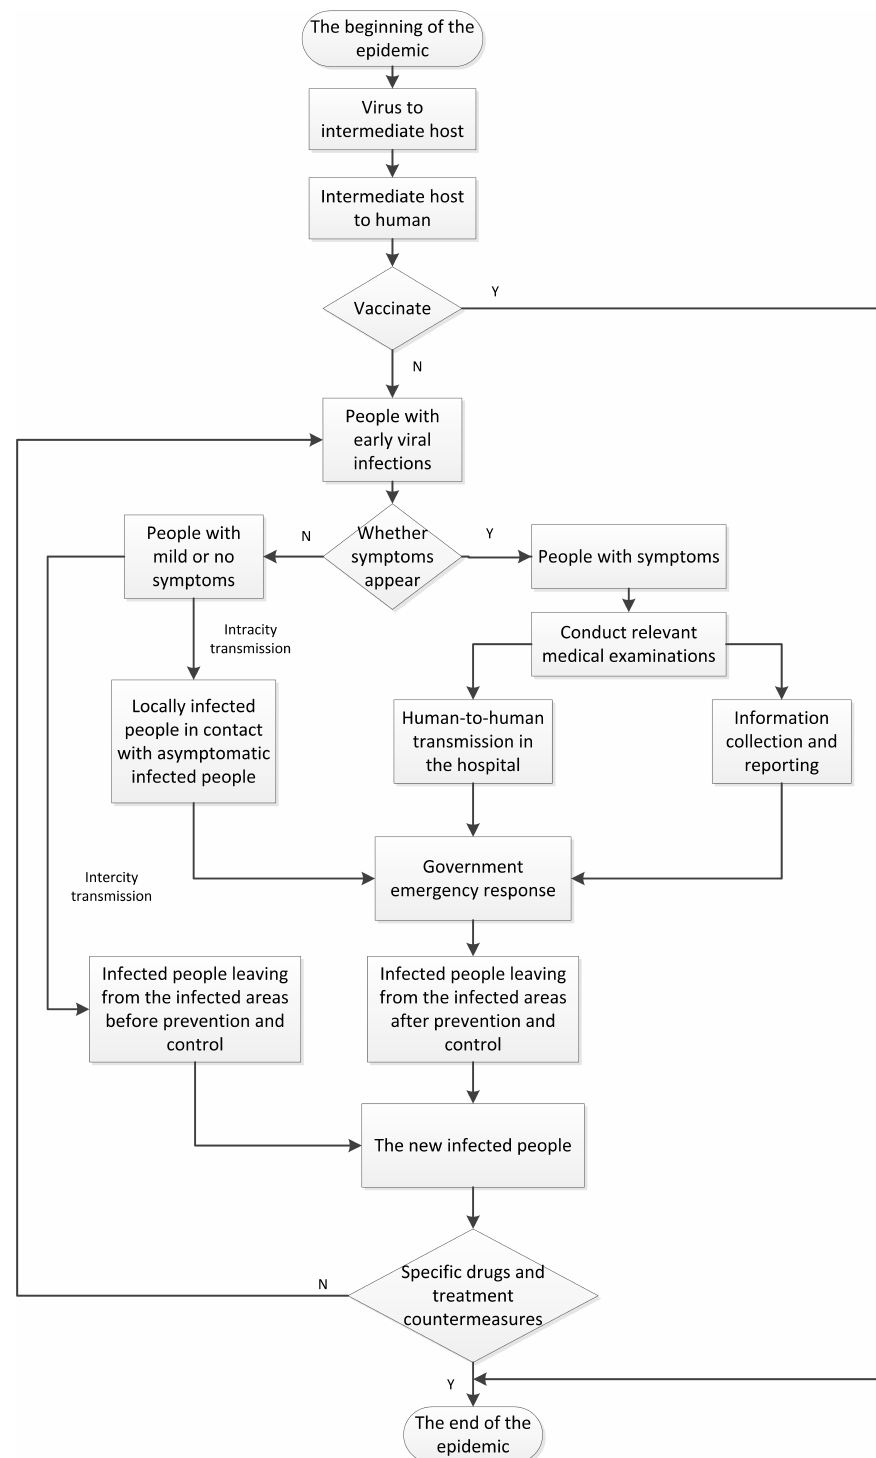
Figure 2. Flowchart of the evolution and transmission process of infectious